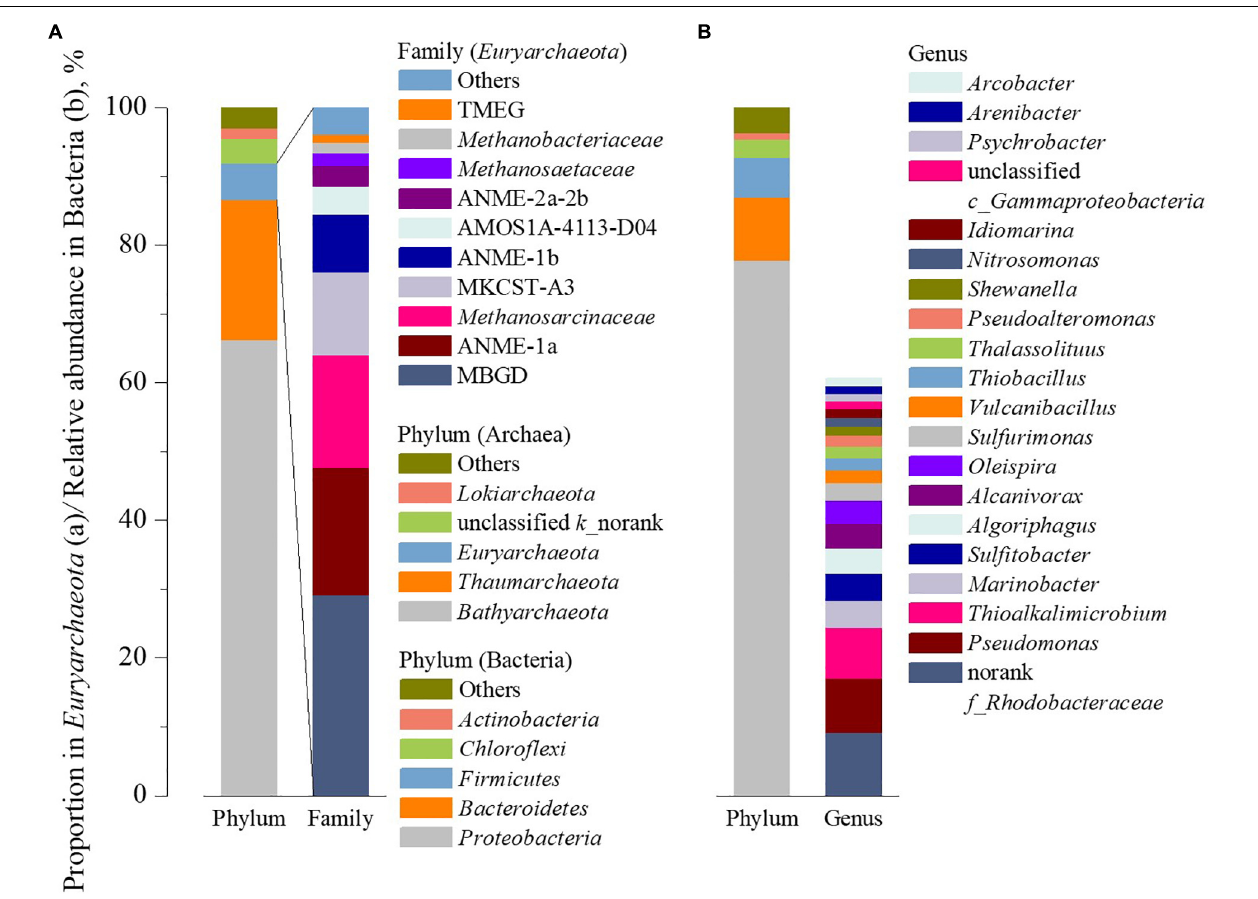
FIGURE 4 | Community composition of archaea (A) and bacteria (B) in the